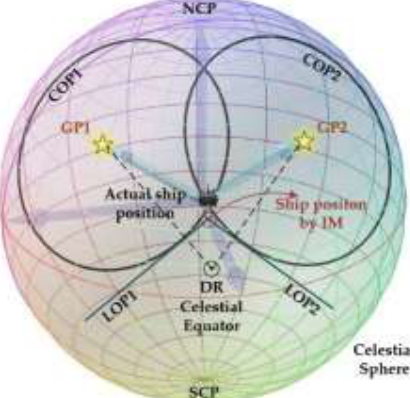
Figure 1. Establishing the line of position (LOP) by the Marcq St. Hilaire method (intercept method).